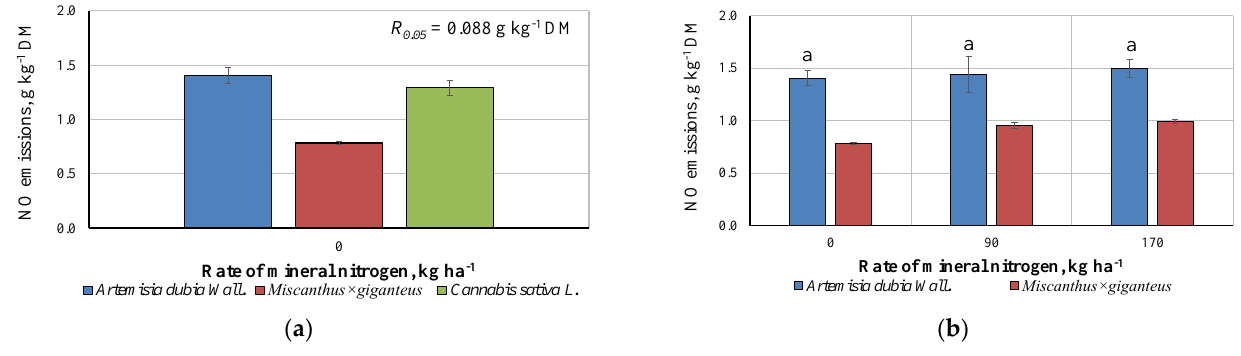
Figure 10. The dependence of NO emissions of Artemisia dubia Wall., Miscanthus×giganteus and Cannabis sativa L. not fertilized ( a ), on mineral nitrogen fertilization ( b ) ( R 0.05 ( A. dubia ) = 0.179 g kg −1 DM, R 0.05 ( M. giganteus ) = 0.034 g kg −1 DM, R 0.05 ( A. dubia × M. giganteus )=0.102 g kg −1 DM. a, there are no statistically significant differences ( p < 0.05) between the columns marked with the same letter, as assessed using the least significant difference.